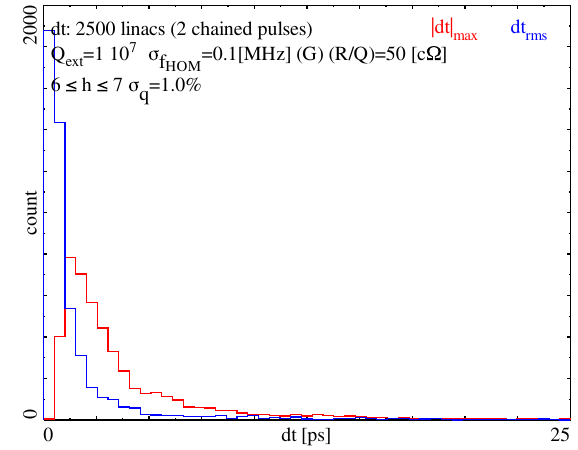
FIG. 23. (Color) Histogram of dE [0–15 MeV, 50 bins] Q ext ¼ 10 7 , worst: red; rms: blue; 2500 different HOM setups; con- ditions as Fig. 11.